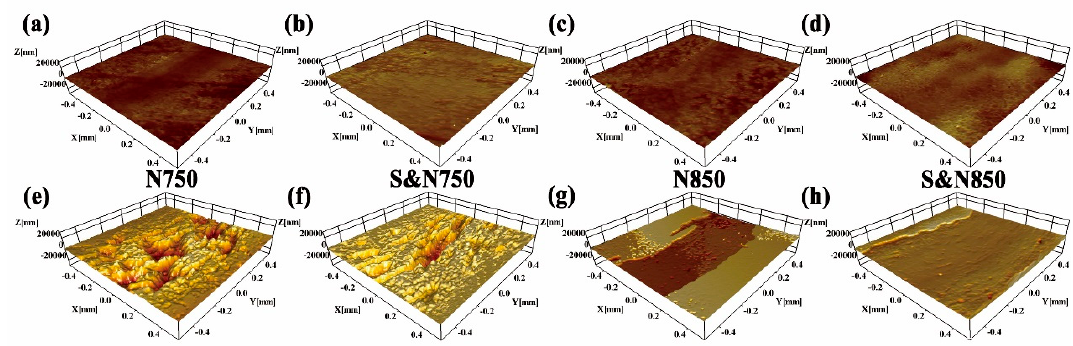
Figure 8. Typical 3D worn surface morphologies of the plasma-nitrided Ti sliding ( a–d ) without and ( e–h ) with abrasive SLRPs. ( e – h ) with abrasive SLRPs.